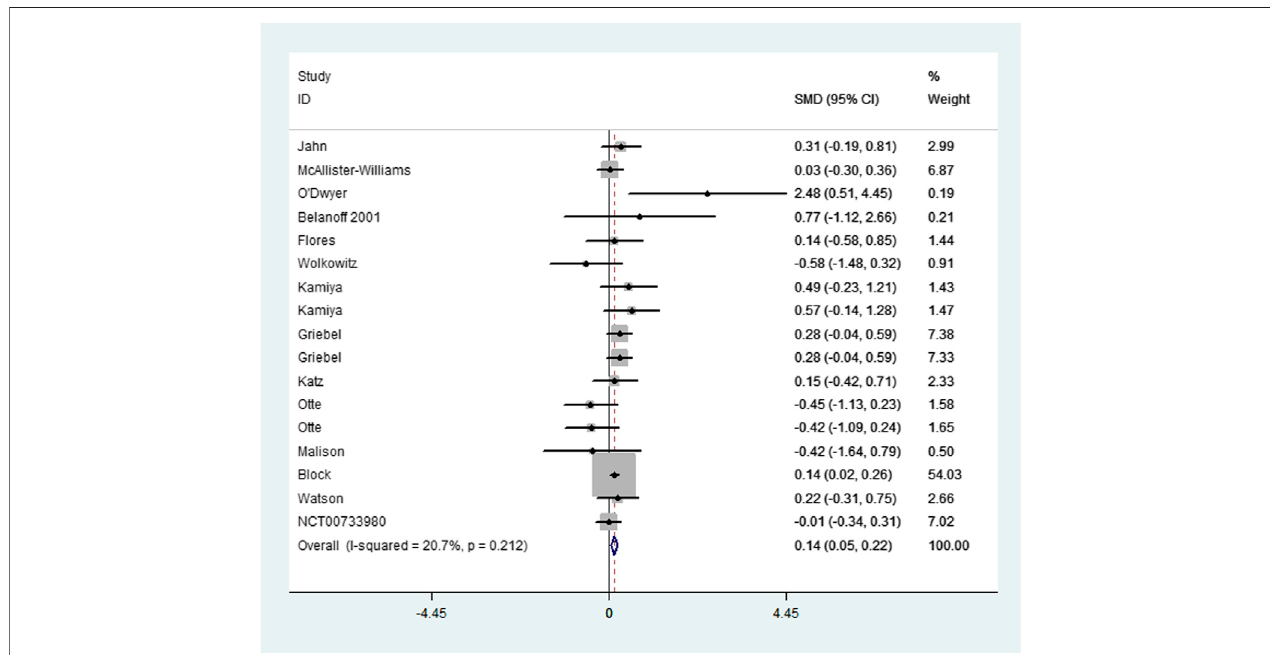
FIGURE 1 | Forest plot and meta-analysis (change data) of the ef fi cacy of HPA-targeting treatments for depression.